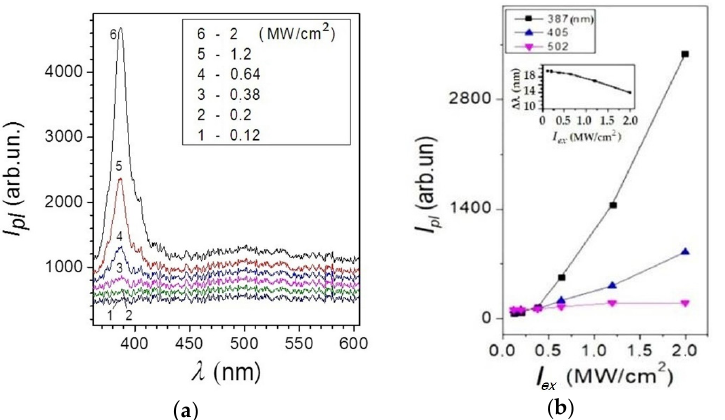
Figure 3. ( a ) Evolution of the PL spectra in the compressed PNMC ZnO powder for different excitation intensities I ex ( λ ex = 337 nm) in the range of 0.12–2 (MW/cm 2 ) at room temperature. ( b ) Dependences of the PL spectral bands intensity I pl versus the excitation intensity I ex ( λ ex = 337 nm) for different wavelengths, nm: 387, 405, 502. Insertion: band half-width Δ λ at 387 nm vs I ex . Hexagonal ZnO microdisks had a distribution with some disordered orientation in space and size variation Figure 4b [25]. In this case, the PL spectrum occurs with a comb- like regular arrangement of ultra-narrow bands (peaks) with halfwidth Δ λ ~ 0.25 nm. Superlinear growth of I Pl in the range of excitation intensities I ex indicates the presence of coherent or “amplitude” FB [18]. Stimulated emission has a mode composition formed by whispering gallery modes (WGM) formed inside (on the faces) of hexagonal microdisks. ( a )